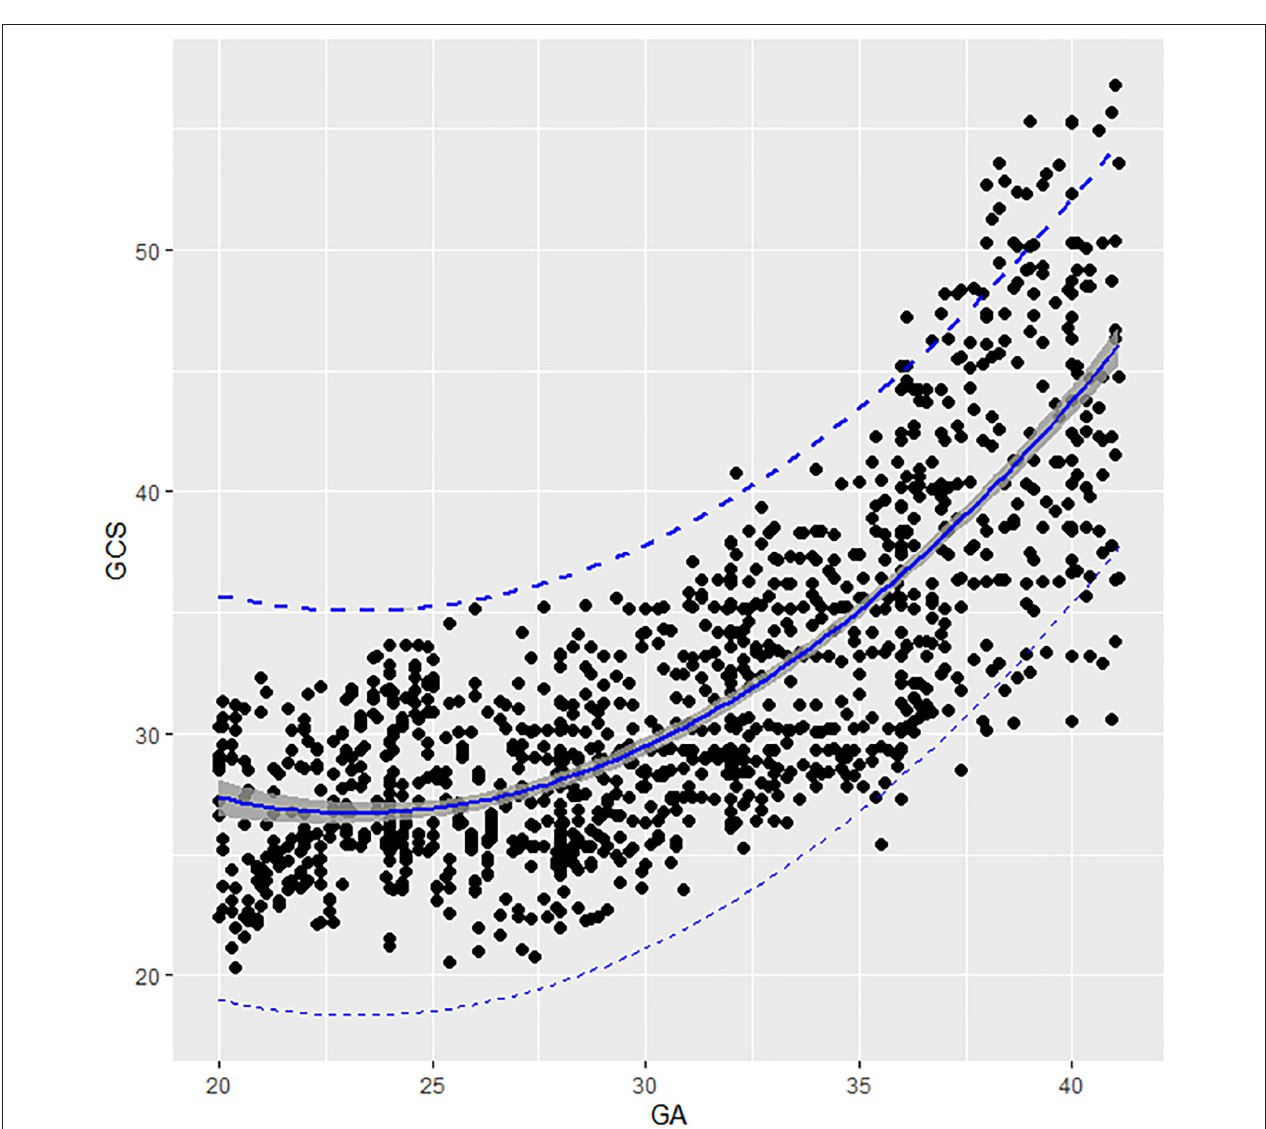
FIGURE 3 | Scatter plots of the GCS based on GA: There was a second-degree fractional polynomial smoothing regression model between GCS and GA. Fitted percentiles according to gestational age are presented as solid lines. The 95% CI of the fitted mean value is presented as a gray area. The 5th and 95th percentile limits are presented as dashed lines. GA, gestational age; GCS, global circumferential strain.